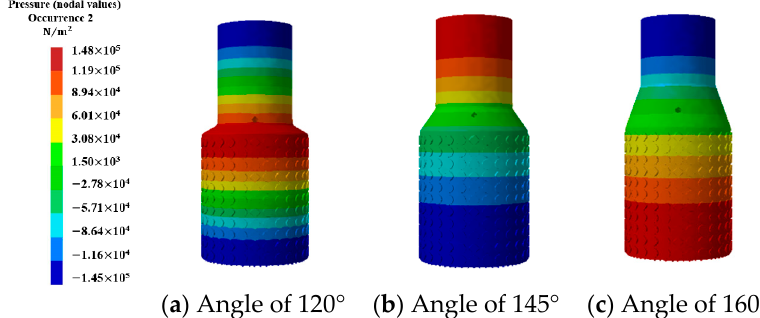
Figure 9. Second-order acoustic cavity modality.